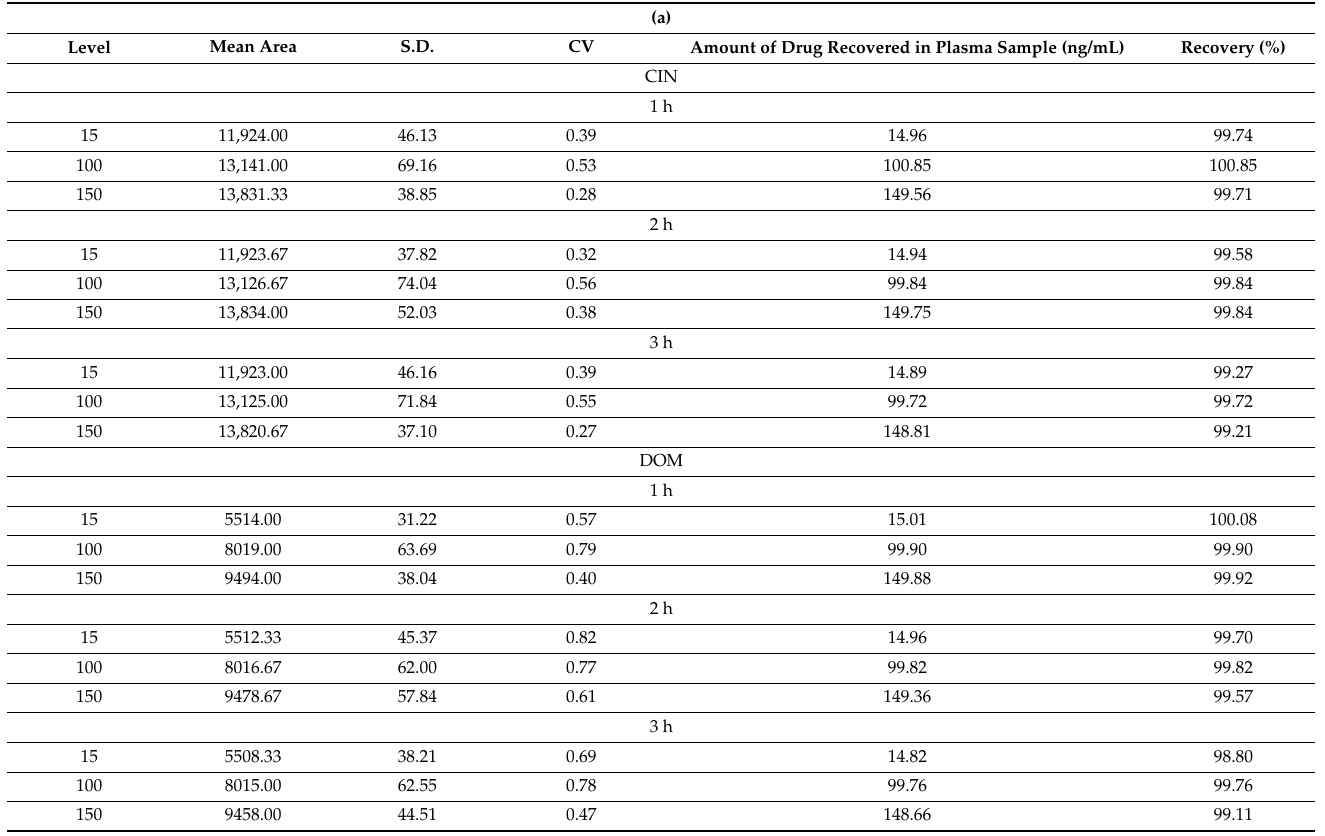
Table 3. ( a ) Short-term stability for plasma samples of CIN and DOM. ( b ) Freeze–thaw stability for plasma samples of CIN and DOM. ( c ) Long-term stability for plasma samples of CIN and DOM.